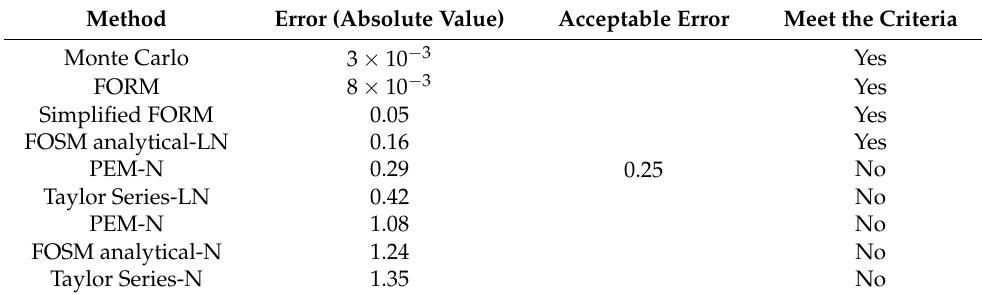
Table 8. Reliability methods suitability assessment for the case of ULS of shallow foundation according to the proposed criteria.